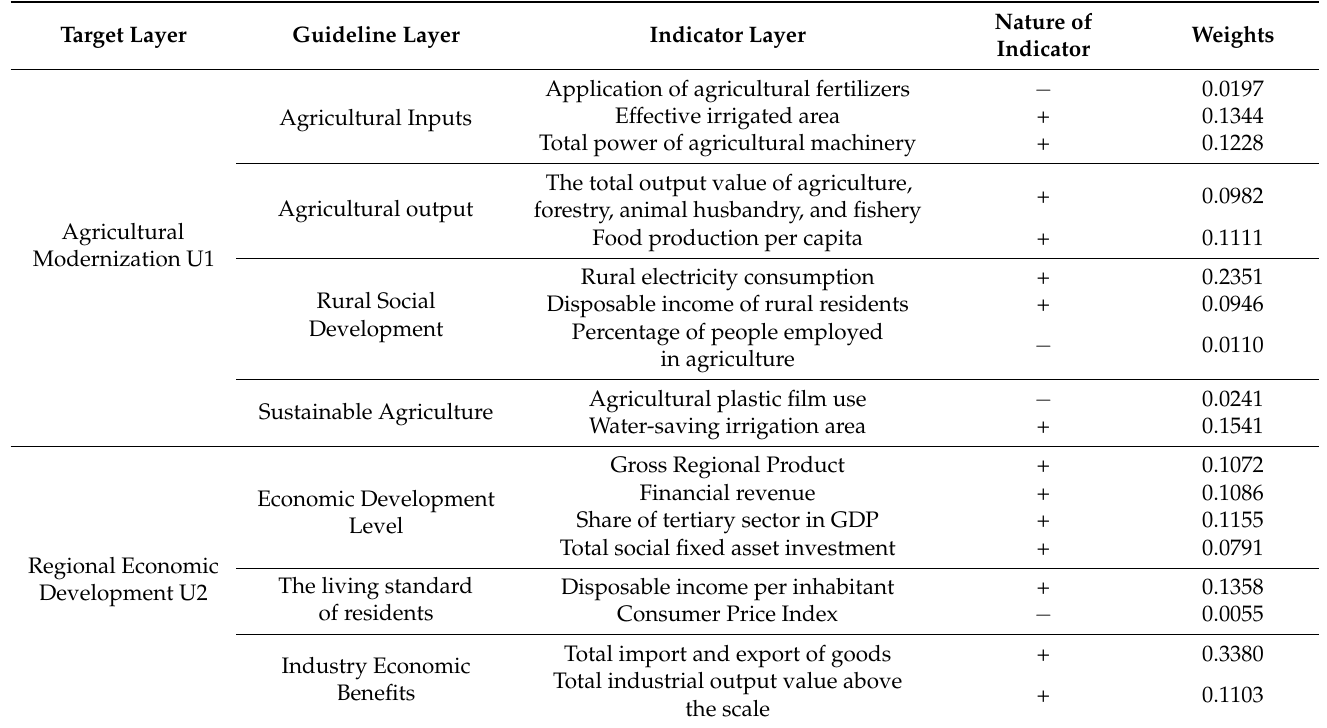
Table 2. Evaluation index